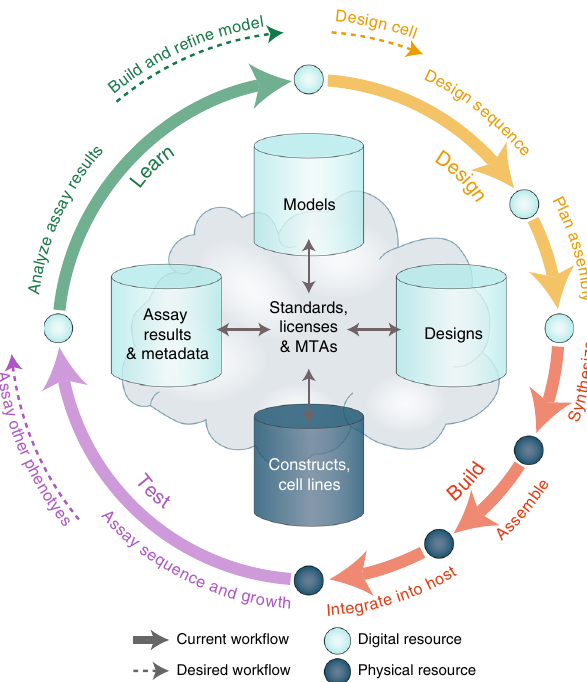
Fig. 2 The emerging design – build – test – learn work fl ow for genome engineering is shown schematically with current (solid arrows) and likely future (dashed arrows) tasks, interfaces (circles), and repositories (cylinders), either digital (light) or physical